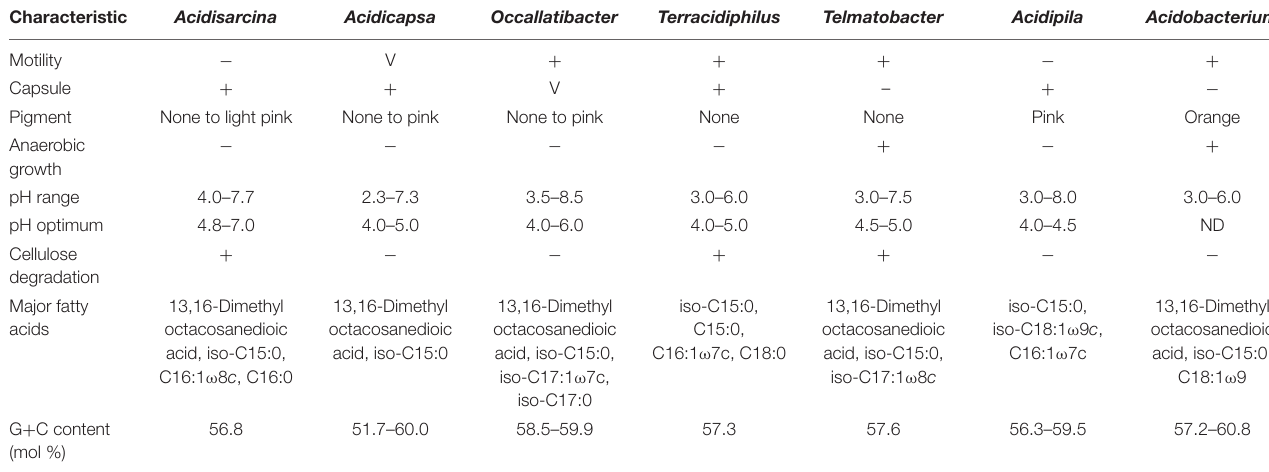
TABLE 5 | Major characteristics that distinguish the genus Acidisarcina from the most closely related genera of the family Acidobacteriaceae